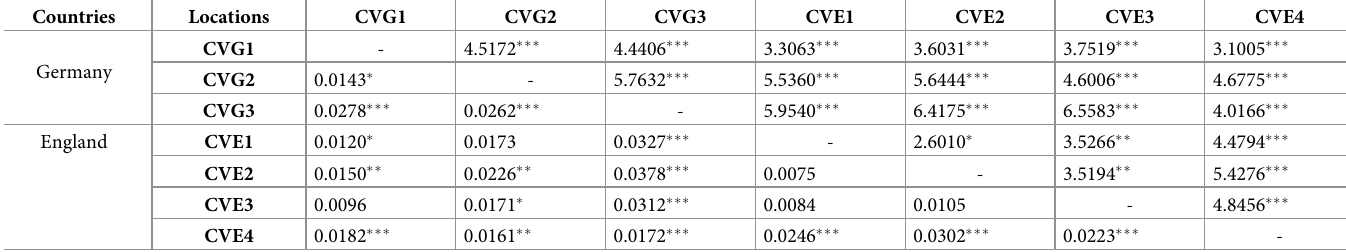
Table 5. Difference in wing shapes of C . vicina from Germany and England analyzed with canonical variate analysis. Mahalanobis distances (above) and Procrustes distances (below).